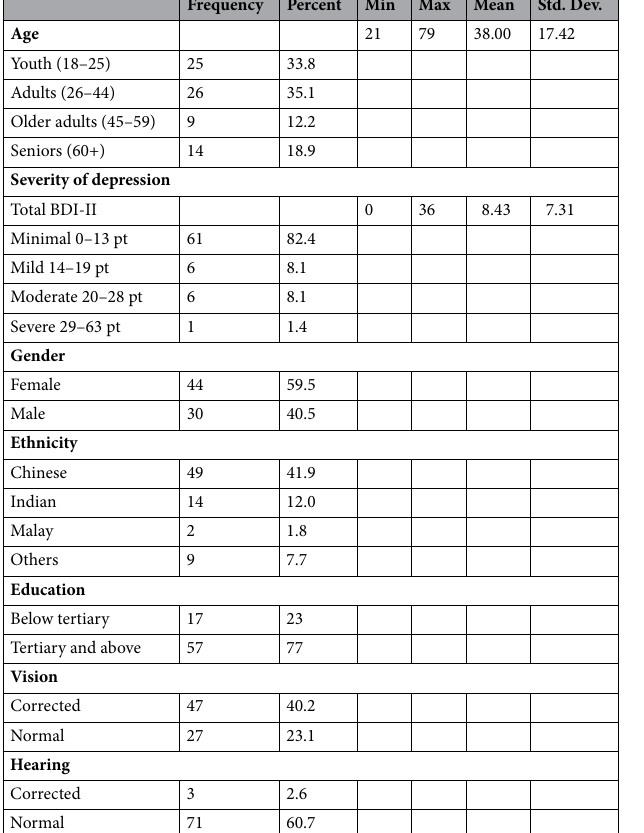
Table 1. Recruited sample